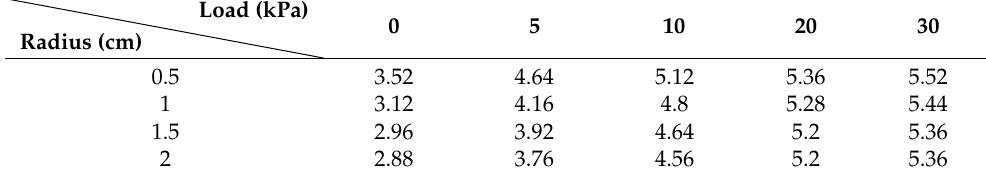
Table 3. The critical gradient of each